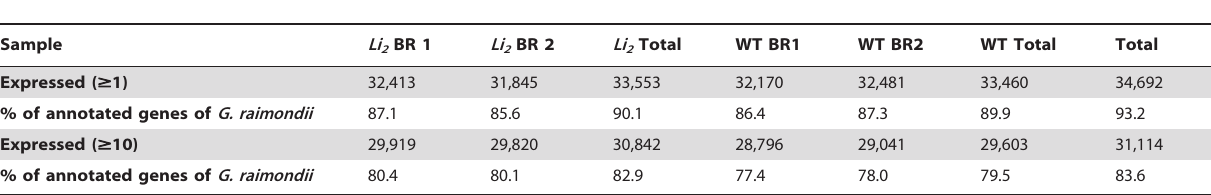
Table 2. Count of expressed